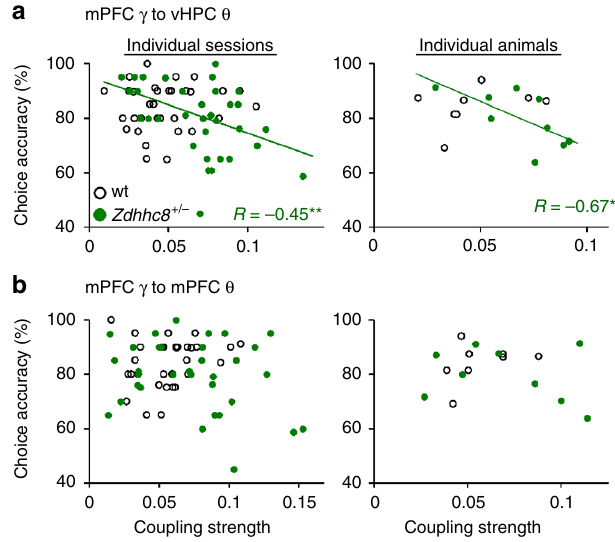
Fig. 3 vHPC theta – mPFC slow gamma coupling in Zdhhc8 + / − mice is inversely correlated with working memory performance. a Scatter plots depicting choice accuracy in a working memory task plotted against coupling strength between mPFC slow gamma and vHPC theta. Left: each session, right: each animal. Only Zdhhc8 + / − mice showed signi fi cant inverse correlation of choice accuracy with coupling strength (Individual sessions: wt; R = 0.14, p = 0.43, Zdhhc8 + / − ; R = − 0.45, p = 0.0089. Individual animals: wt; R = 0.34, p = 0.41, Zdhhc8 + / − ; R = − 0.67, p = correlation. b Choice accuracy did not correlate with theta-slow gamma coupling within mPFC. (Individual sessions: wt; R = 0.21, p = 0.20, Zdhhc8 + / − ; R = − 0.25, p = 0.15. Individual animals: wt; R = 0.36, p = 0.38, Zdhhc8